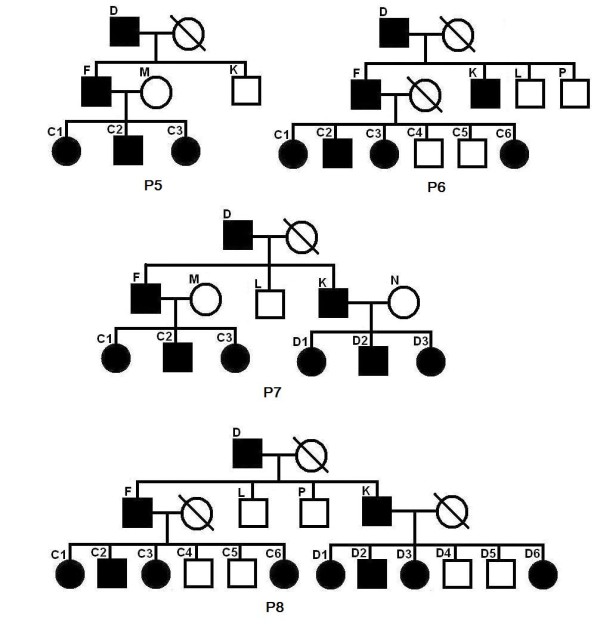
Pedigrees P5 to P8.